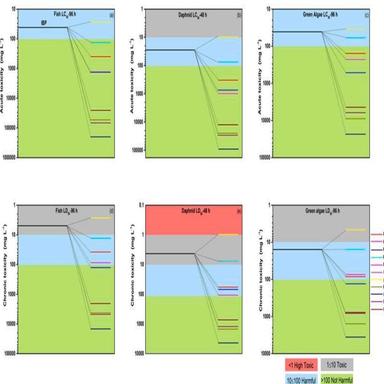
Acute (a–c) and chronic (d–f) toxicity analysis of intermediate products of IBP by ECOSAR simulation.